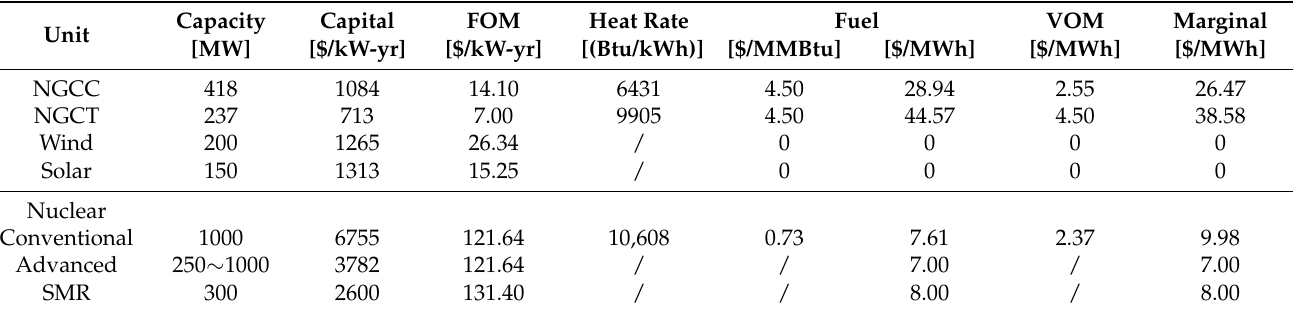
Table 3. Estimates of Cost of Energy